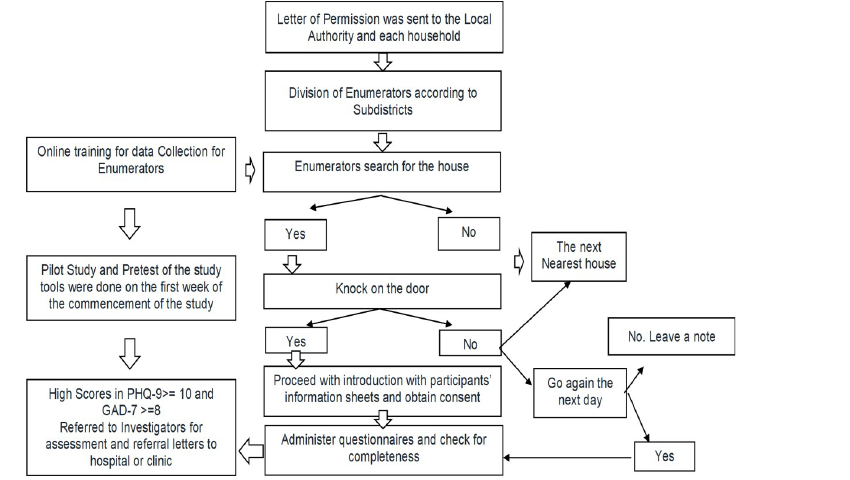
Fig 2. The flow chart of the data